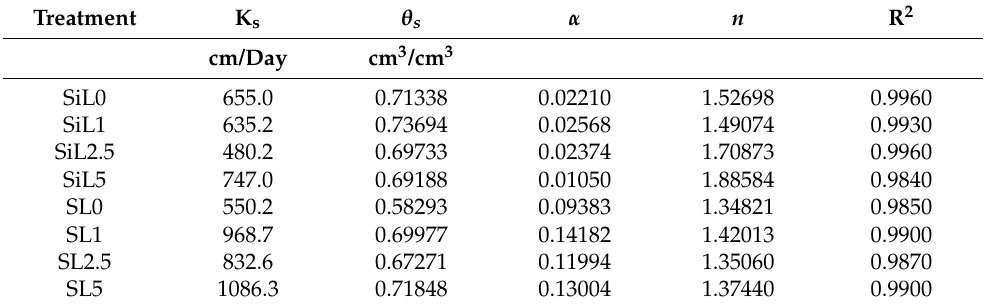
Table 4. Soil hydraulic fitted parameters based on the van Genuchten–Mualem model ( m = 1–1 /n ), shown in Figure 5.